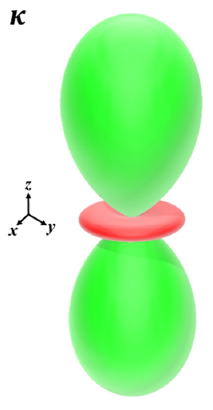
Figure 5. Compressibility of ZIF-75 as a function of the applied strain. The negative and positive values are displayed in red and green, respectively.